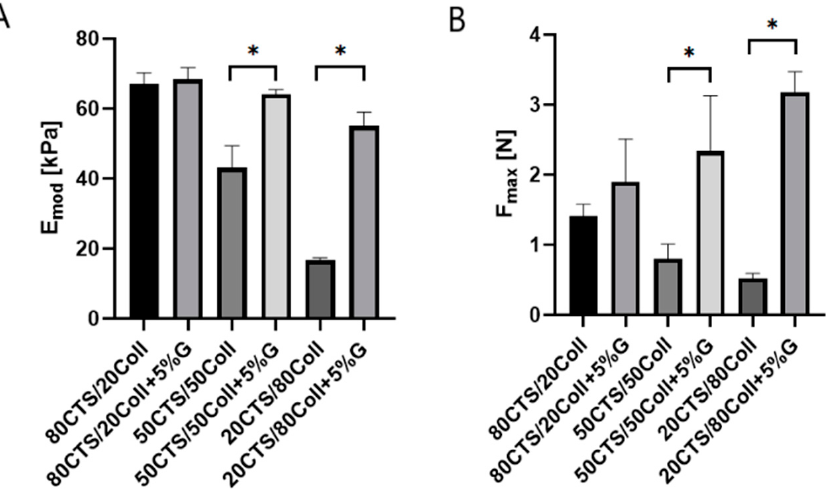
Figure 2. The compressive modulus (E mod ) ( A ) and maximum force (F max ) ( B ) obtained for the scaffold during the compression; * p < 0.001.